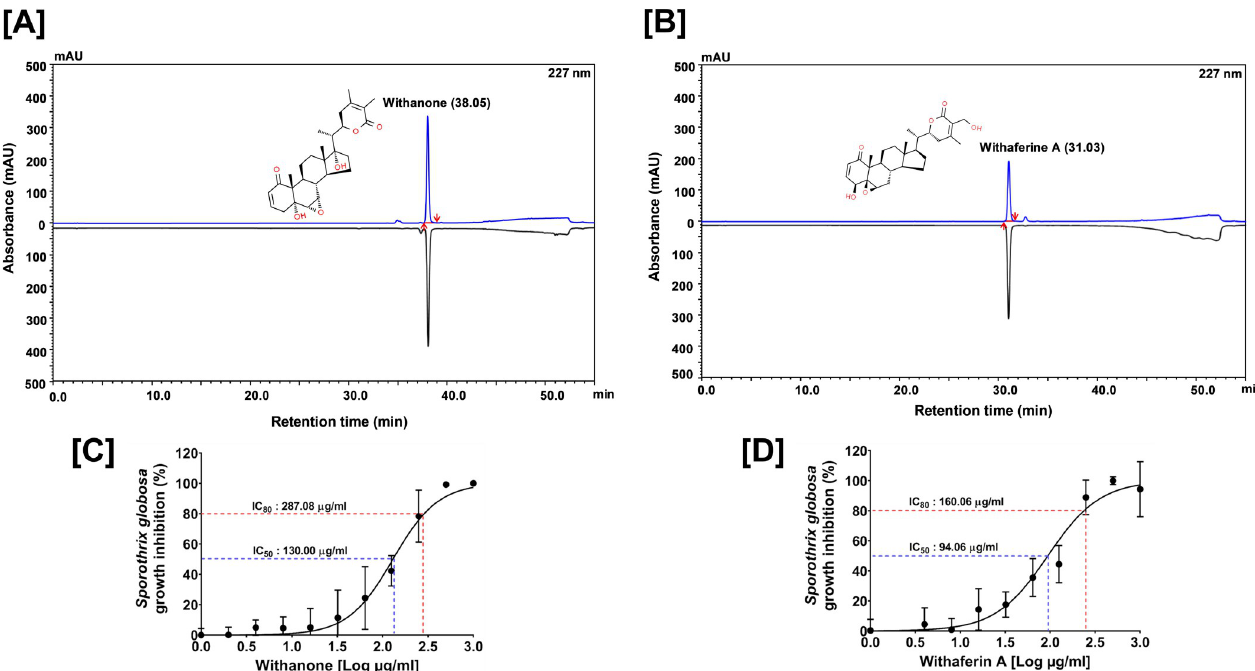
Fig 8. Effect of withanone and withaferin A purified from WSWE on S . globosa cells. [A, B] Mirror HPLC chromatograms of standard mix (black) and purified withanone (blue) (A)/withaferin A (B) recorded at 227 nm. [C, D] Dose response curves of withanone (A) and withaferin A (B) demonstrating anti- sporotrichotic effects against S . globosa cells. IC 50 and IC 80 values are indicated.